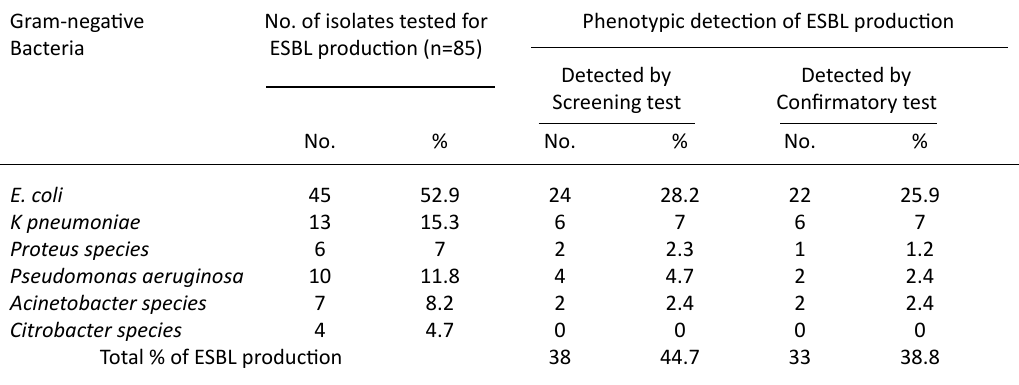
table 2. ESBL production among gram-negative bacilli from surgical site infections Gram-negative No. of isolates tested for Phenotypic detection of ESBL production Bacteria ESBL production (n=85)